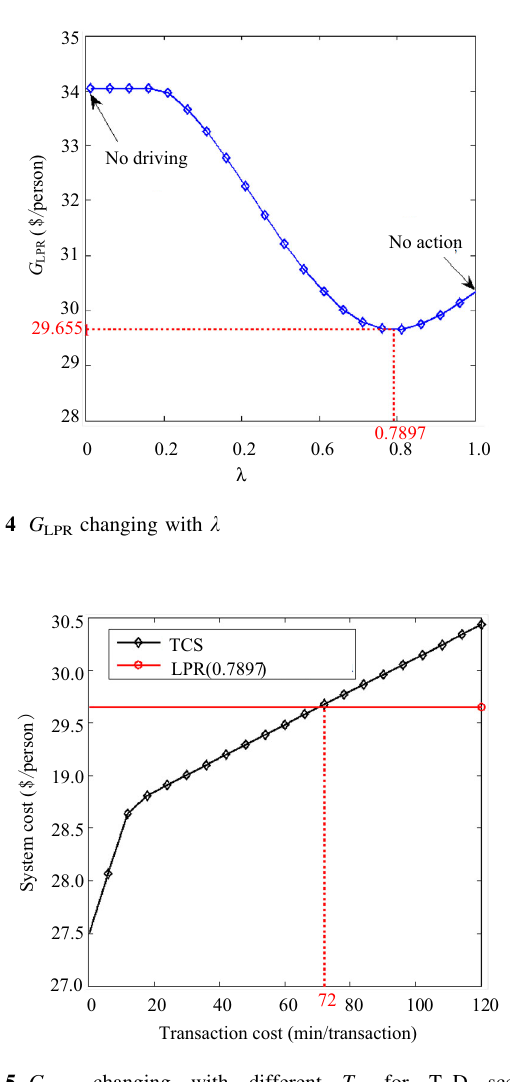
Fig. 5 G TCS changing with different T C for T–D scenario ( k = 0.7897)